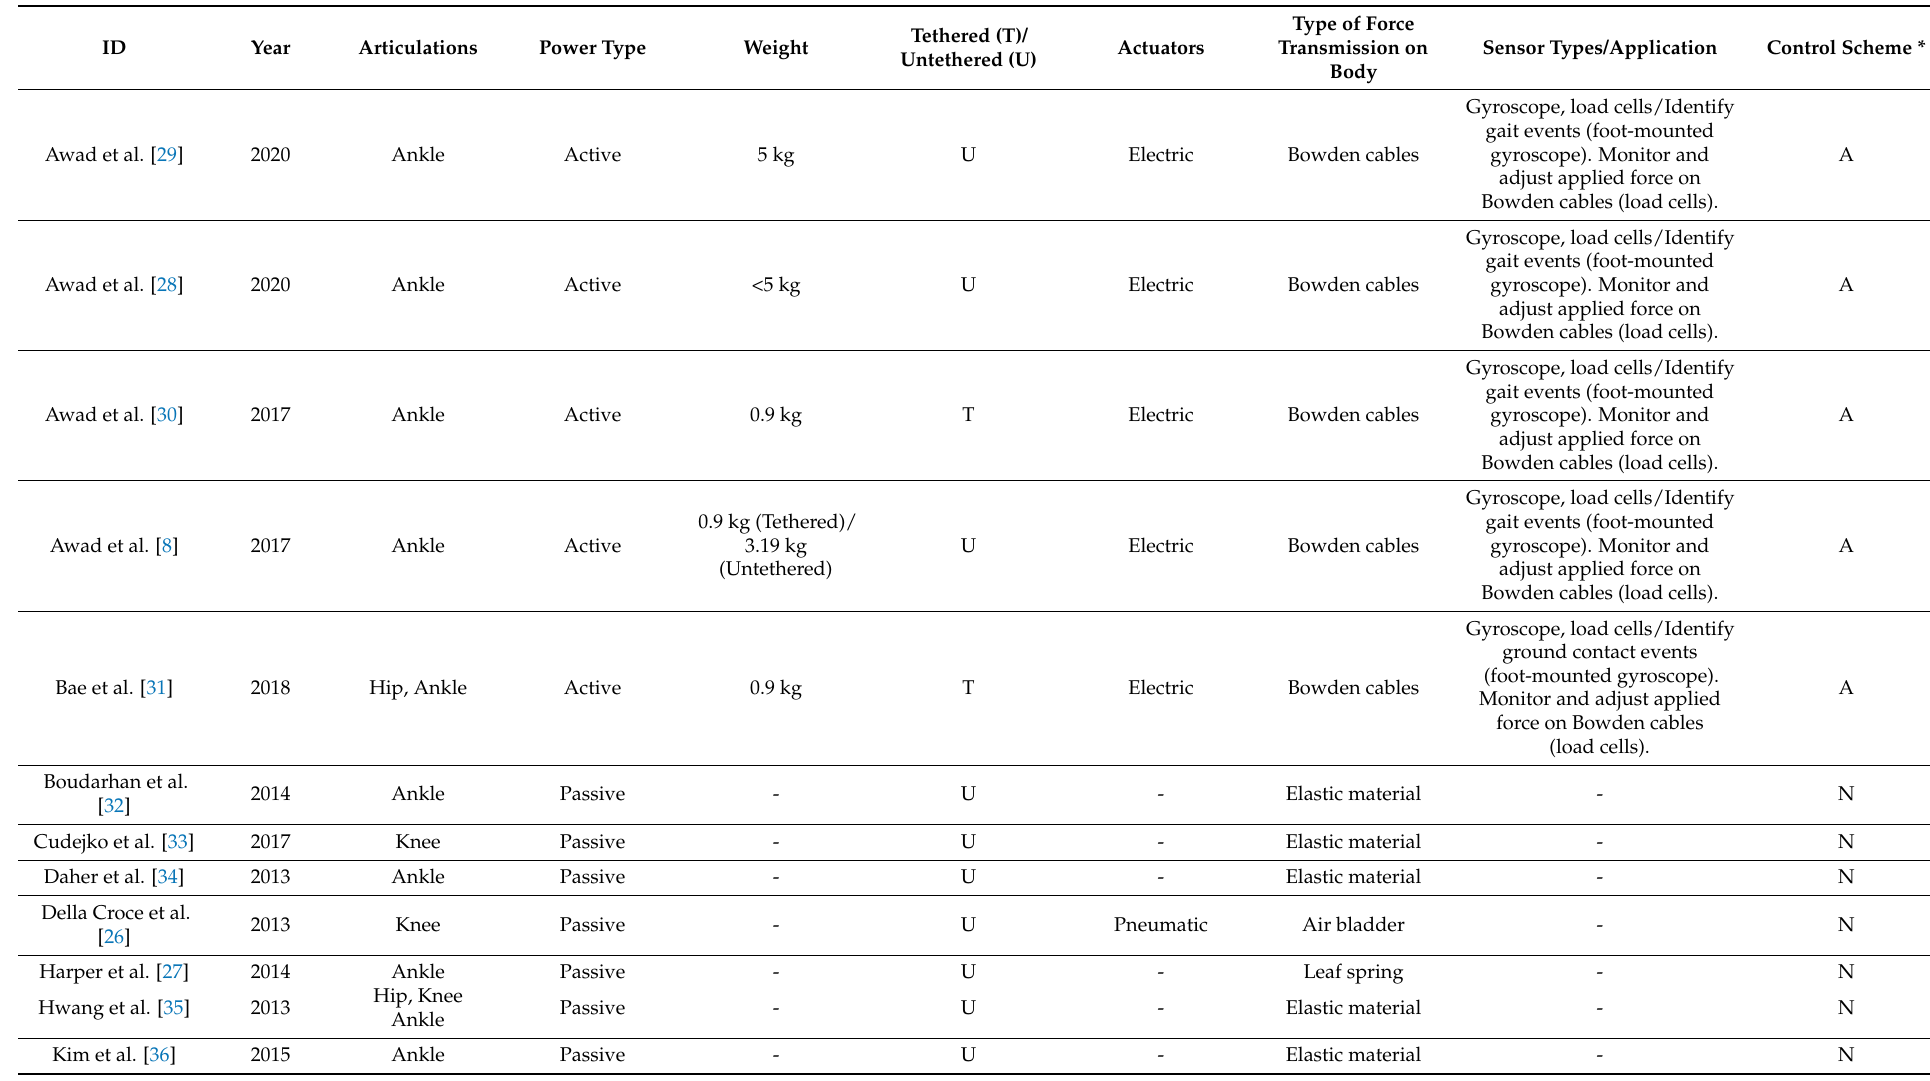
Table 3. Exosuit technological features extracted from the relevant